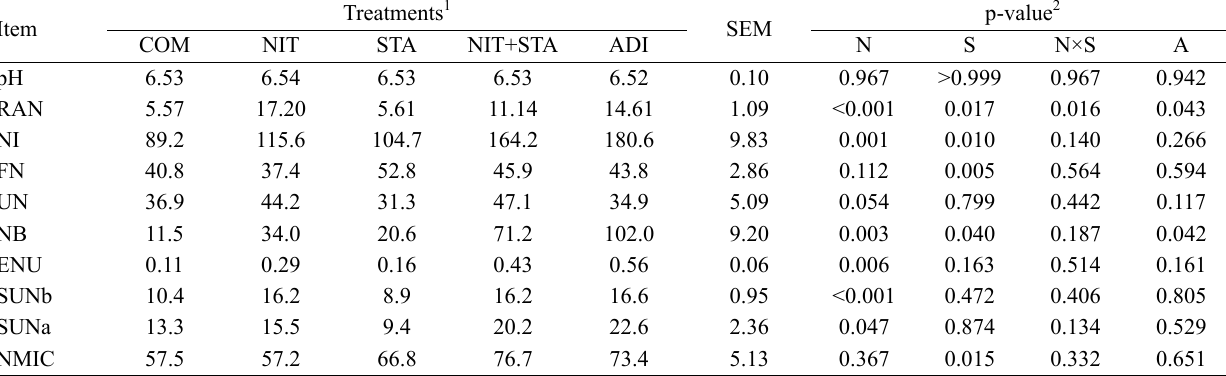
Table 6. Least squares means of ruminal pH, concentration of ruminal ammonia nitrogen (RAN; mg/dL), nitrogen intake (NI; g/d), fecal nitrogen (FN; g/d), urinary nitrogen (UN g/d), apparent balance of nitrogen compounds (NB; g/d), efficiency of nitrogen utilization (ENU; g/g nitrogen intake), serum concentrations of nitrogen urea before (NUSb; mg/dL) and after supplementation (NUSa; mg/dL) and production of microbial nitrogen in the rumen (NMIC g/d) according to the treatments